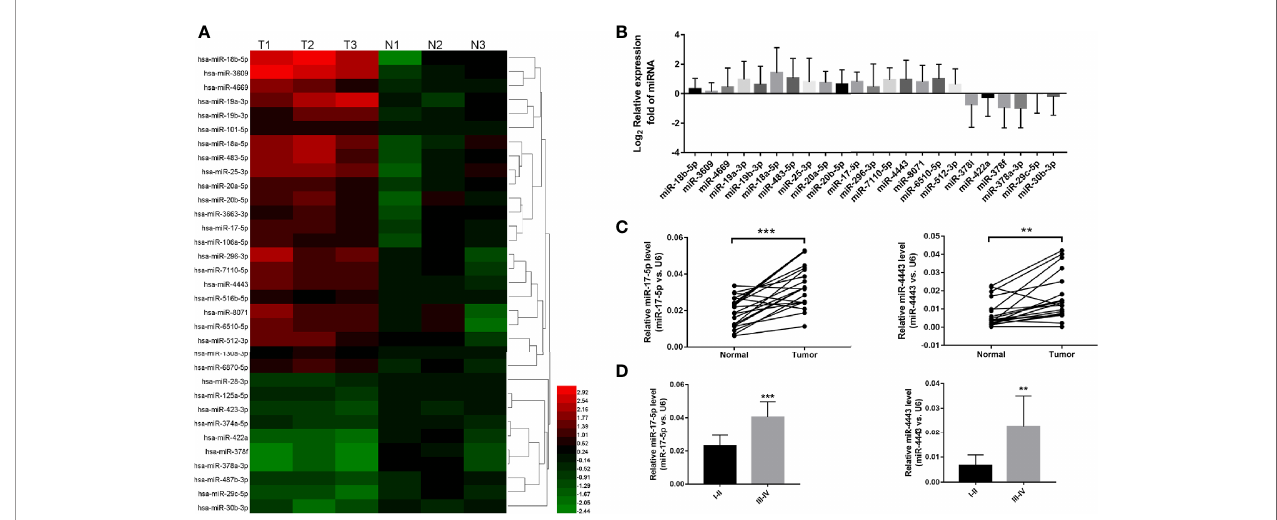
FIGURE 1 | The expression level of miR-17-5p and miR-4443 in ESCC tissues. (A) high-throughput miRNA sequencing results. 23 miRNAs were statistically dysregulated, P<0.05, fold change>2 or <0.5. (B) Q-PCR analysis of all 23 screened miRNAs in 20 ESCC tissues and normal adjacent tissues. (C) Q-PCR analysis of the relative expression levels of miR-17-5p and miR-4443 in 20 pairs tissues. (D) The two miRNAs concentrations in different TNM stages (I – IV) of all 20 ESCC tissues. **P < 0.01, ***P <